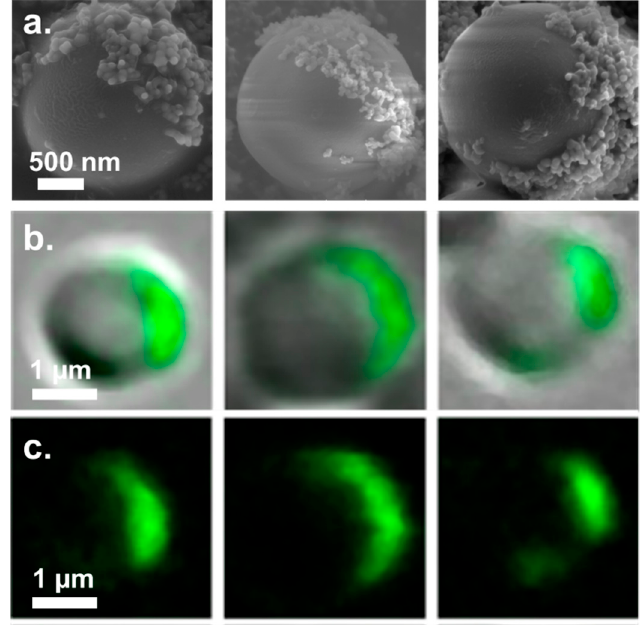
Figure 7. ( a ) HRSEM images of PMSQ-COOH amphiphilic Janus particles decorated with covalently immobilized amine functionalized silica nanoparticles (NPs). The silica-NH 2 NPs are reacting with the carboxyl groups of the PMSQ-COOH via 1-Ethyl-3-(3-dimethylaminopropyl)carbodiimide (EDC)/ N -Hydroxysuccinimide (NHS) amidation. ( b ) Overlay confocal microscopy images of the PMSQ-COOH amphiphilic Janus particles labeled with 6-aminofluorescein. ( c ) Fluorescein signal only.